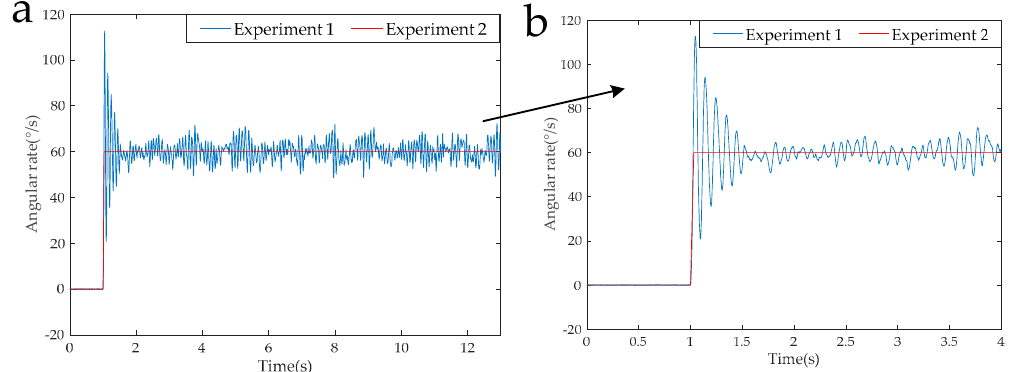
Figure 11. ( a ) Modulation angular rates of Experiment 1 and Experiment 2. ( b ) THE partial enlarged view of modulation angular rates.